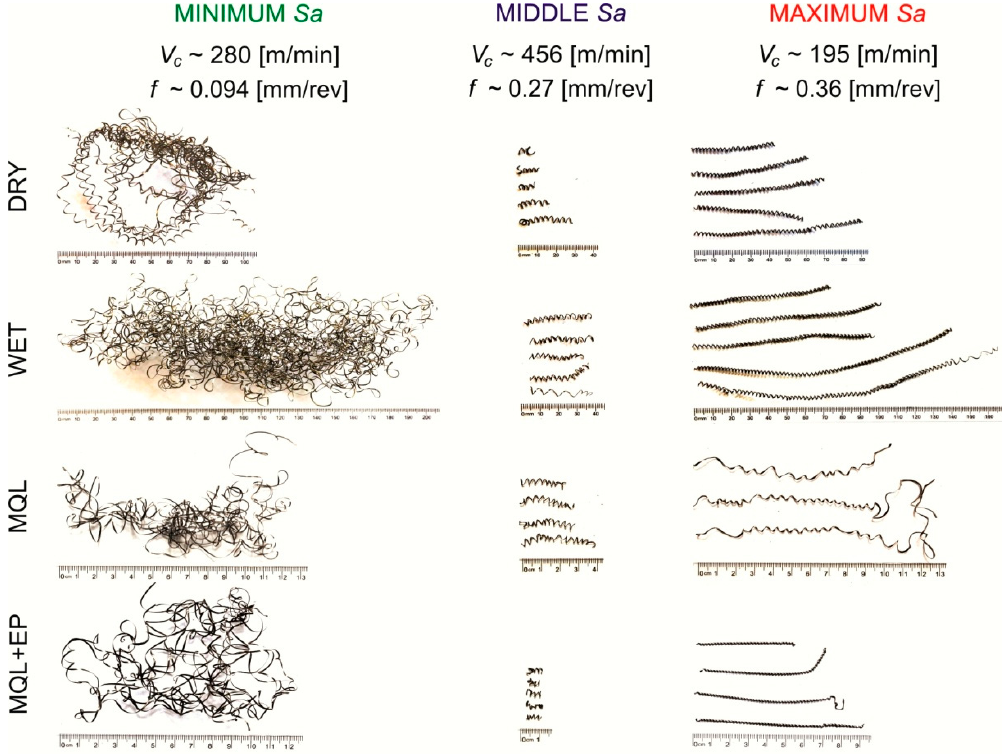
Figure 2. Chip shapes after finish turning of the steel tested.